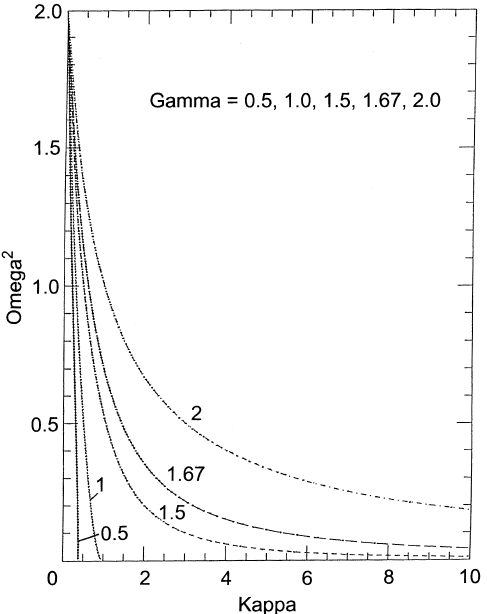
Fig. 1. The square of the frequency of small-amplitude, undamped oscillations plotted as a function of parameter (cid:106) for different polytropes ( (cid:99) (cid:136) 1 = 2 ; 1 ; 3 = 2 ; 5 = 3 ; 2). All frequencies are below (cid:120) (cid:136) 2 1 = 2 ; which corresponds to the oscillations of a zero-beta